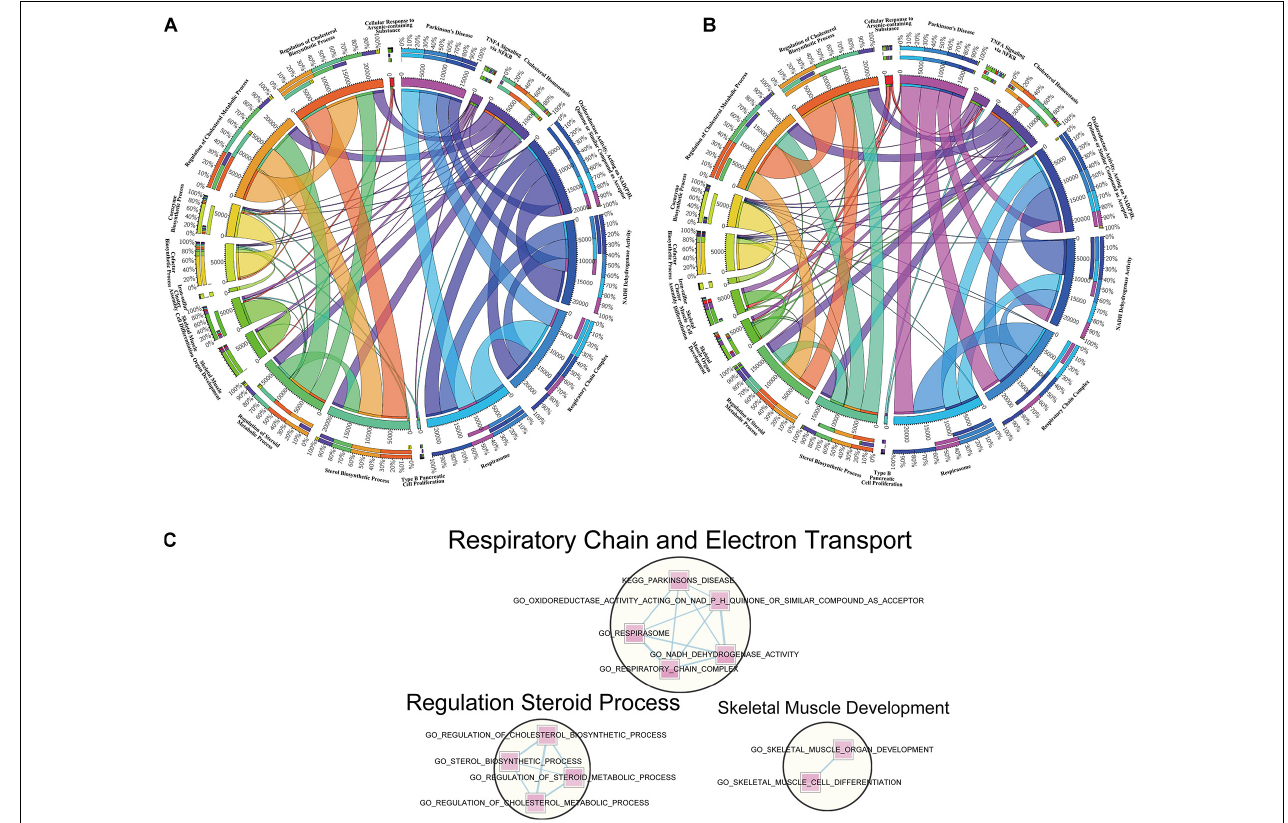
FIGURE 5 | Leading-edge analysis of downregulated overlapped pathways. (A) Circos diagram presents a circular visualization of connection patterns in cortex within the 18 pathways chosen from overlapped downregulation. (B) Circos diagram utilizes a circular layout to facilitate the display of interaction patterns in hippocampus within the 18 pathways chosen from overlapped downregulation. The width of line represents various degrees to the relevance among pathways. (C) Enrichment networks reveal the important clusters achieved from the 18 overlapped downregulated gene sets. The pathways in circles represent the functionally associated sub-modules in the overall networks based on the topological structures, with the functional annotation displayed